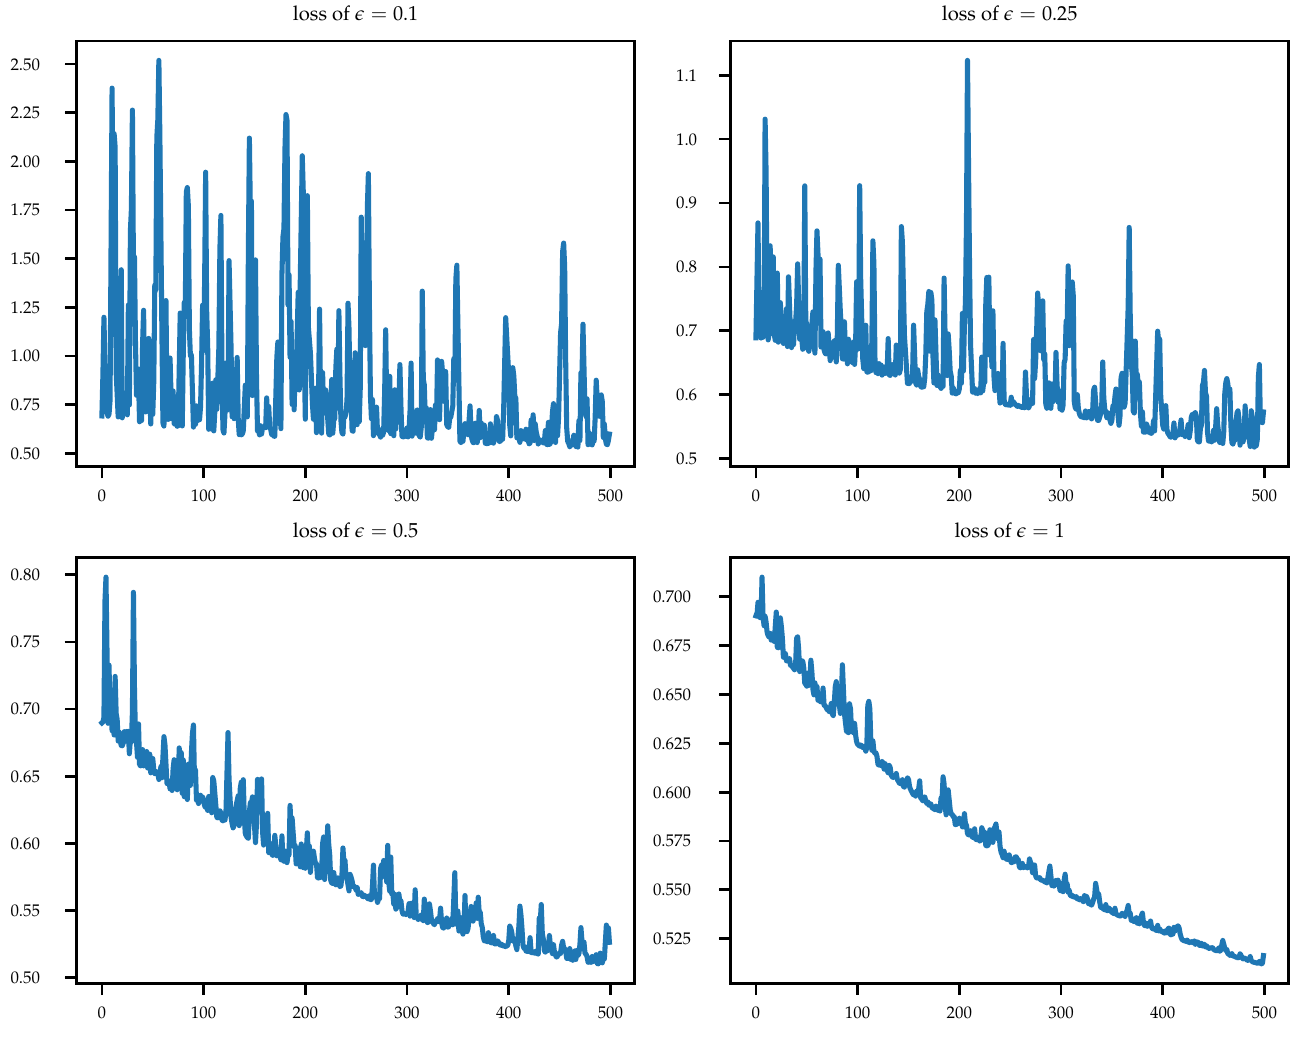
Figure 2. Training convergence under different privacy budgets.